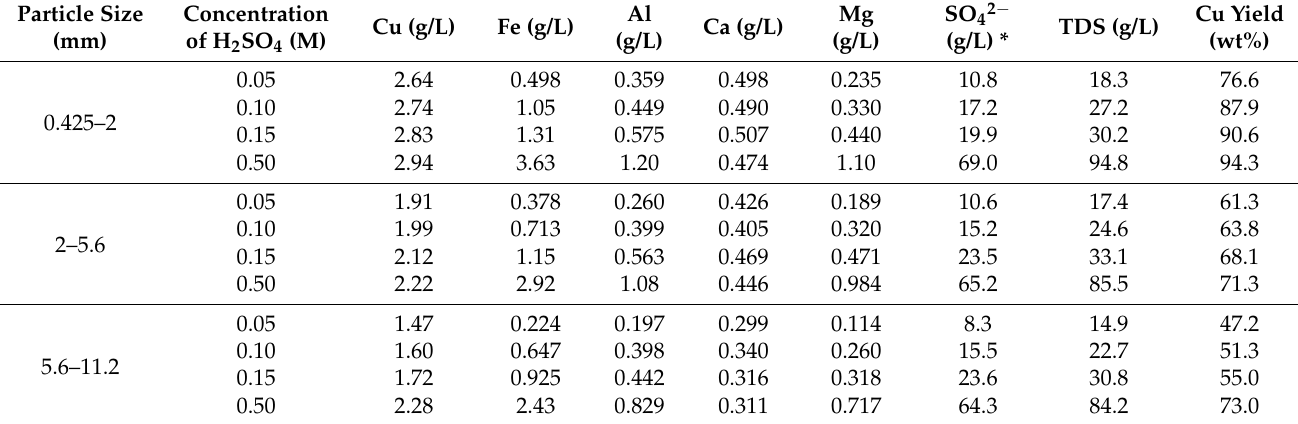
* Calculated from the amount of H 2 SO 4 added to the solution (the pH of the suspension was adjusted to initial pH by adding 5 M H 2 SO 4 solution when more than 50% of the initial acid was